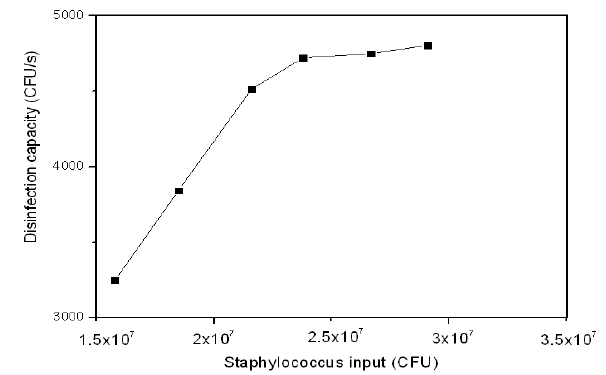
Figure 6. Disinfection capacity of Staph by 7.5% Ag-TiO Staph inputs.